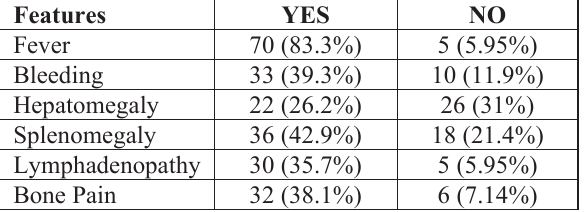
Table-1: Clinical features of ALL